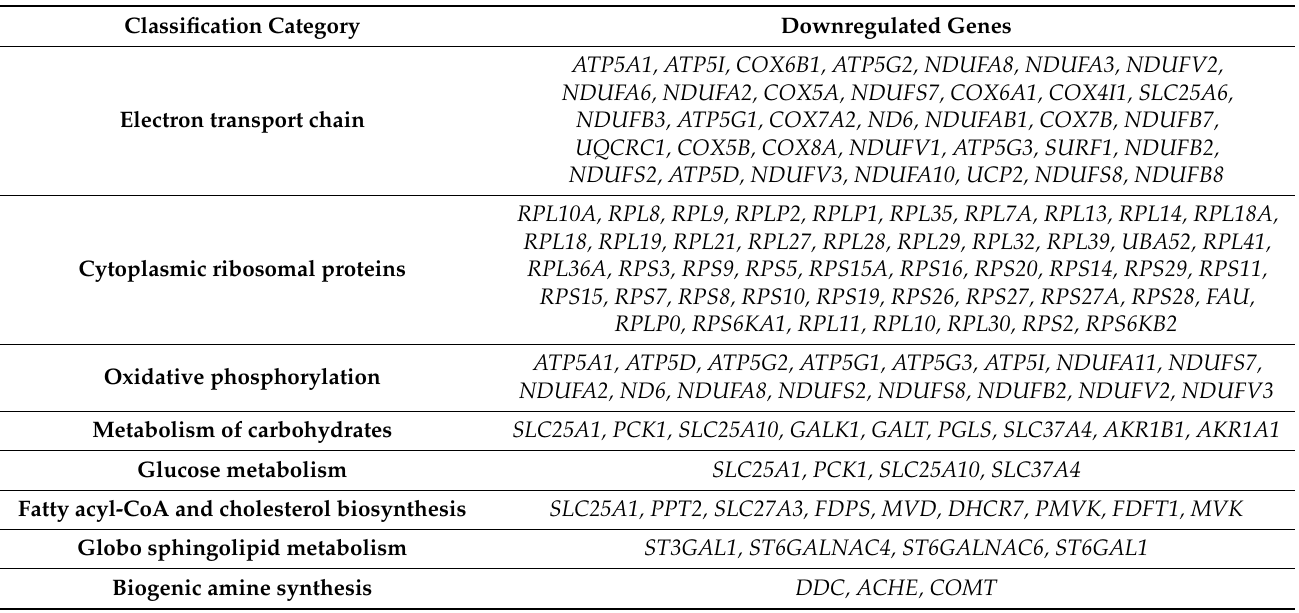
Table 2. Summary of the P-bi-TAT-therapy-mediated interference with energy-producing, protein synthesis and essential metabolic pathways of human primary culture glioblastoma multiforme (GBM)